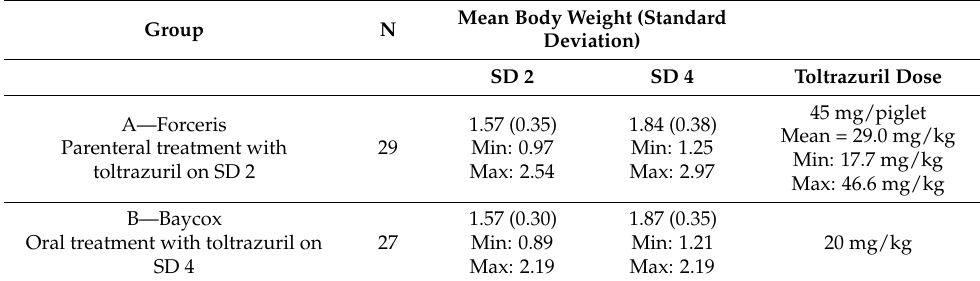
Table 1. Body weights on the day of treatment and treatment doses of the two treatment groups. Mean Body Weight (Standard Group N Deviation) SD 2 SD